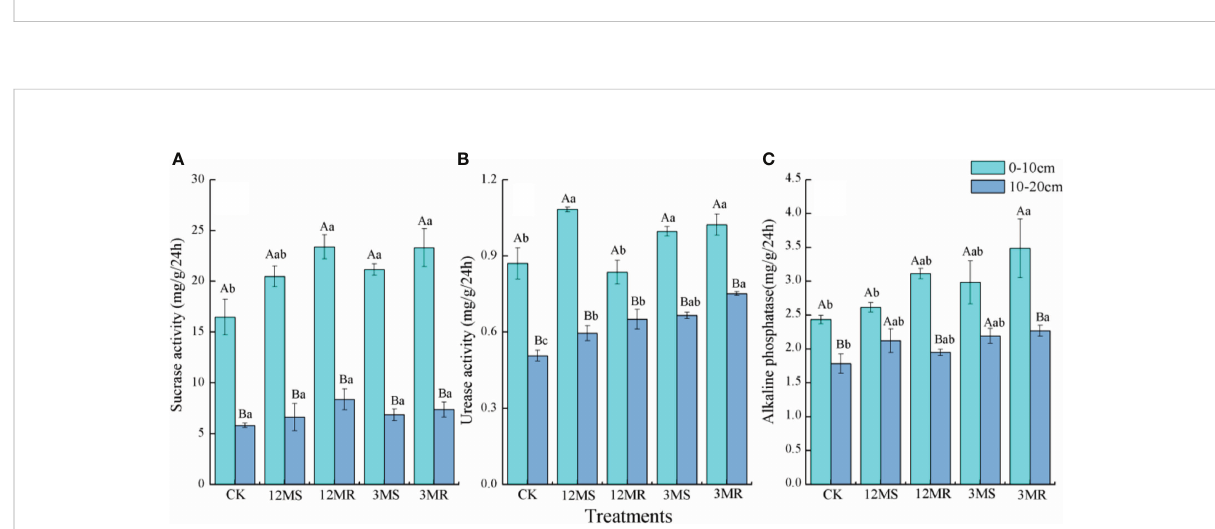
FIGURE 4 Sucrase activity (A) , urease activity (B) , and alkaline phosphatase activity (C) under different treatments. Data are mean ± SD (n = 4). Different lowercase letters represent signi fi cant differences under different treatments. Different capital letters indicate signi fi cance between 0- to 10-cm and 10- to 20-cm soil layers of each